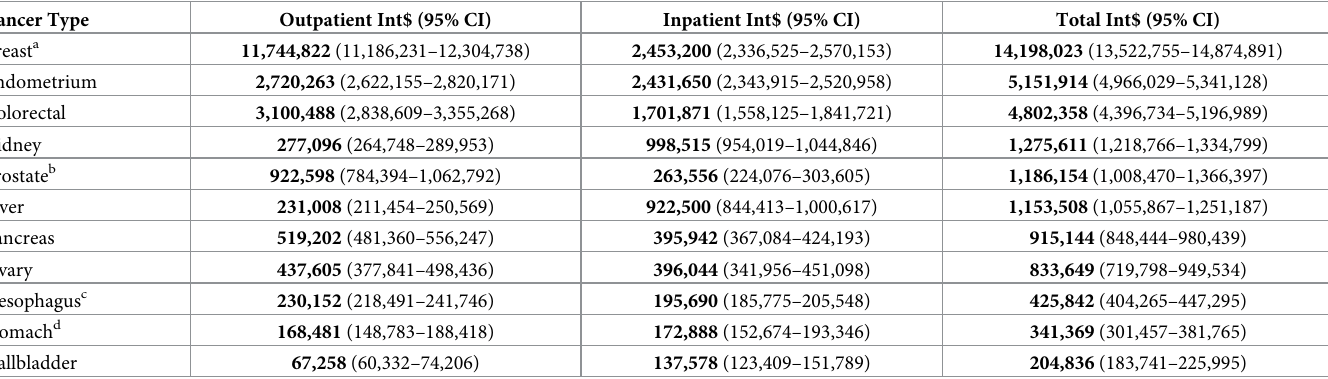
Table 3. Federal costs of cancer attributable to excess body weight and respective confidence intervals. Brazil,